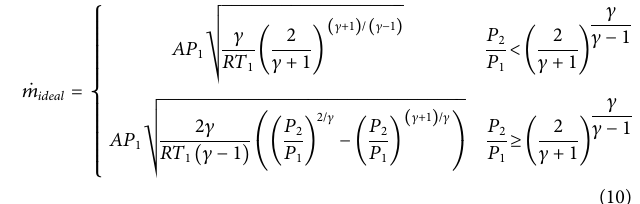
Frontiers in Energy Research |